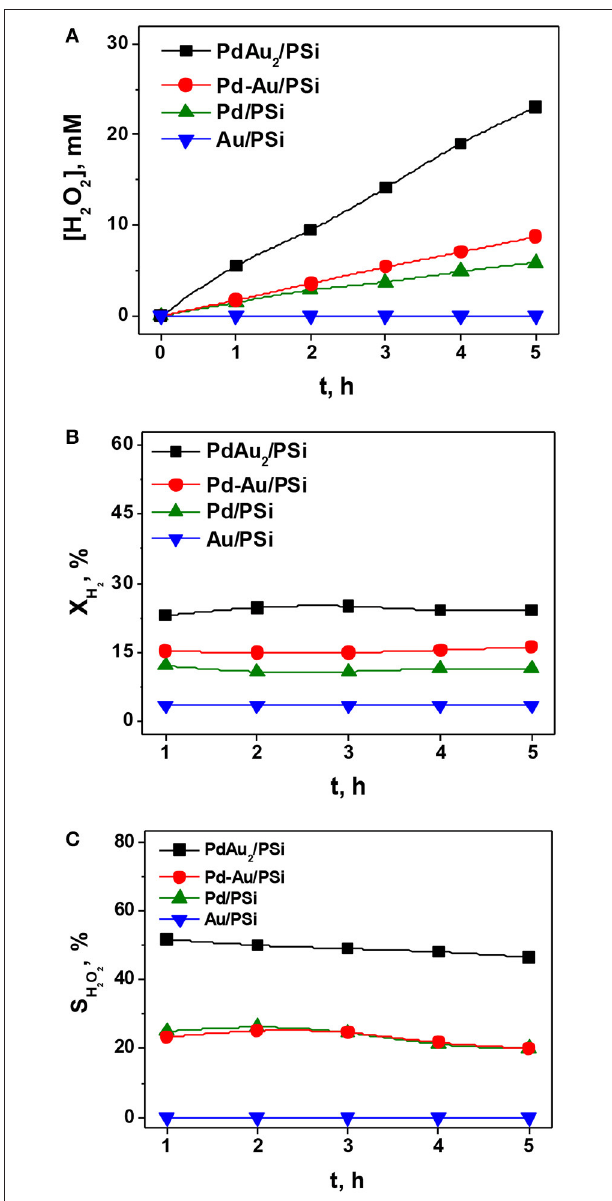
FIGURE 6 | The time course of the H 2 O 2 concentration (A) , H 2 conversion (B) , and H 2 O 2 selectivity (C) for the direct H 2 O 2 synthesis over the Pd/PSi, Au/PSi, Pd-Au/PSi, and PdAu 2 /PSi catalysts. P = 1 bar. T = − 10 ◦ C. Reaction media: 100mL of a 0.03M H 2 SO 4 methanol solution. Gas flow rate: 2ml (STP) min − 1 H 2 and 48ml (STP) min − 1 O 2 . Catalyst loading: 50mg.